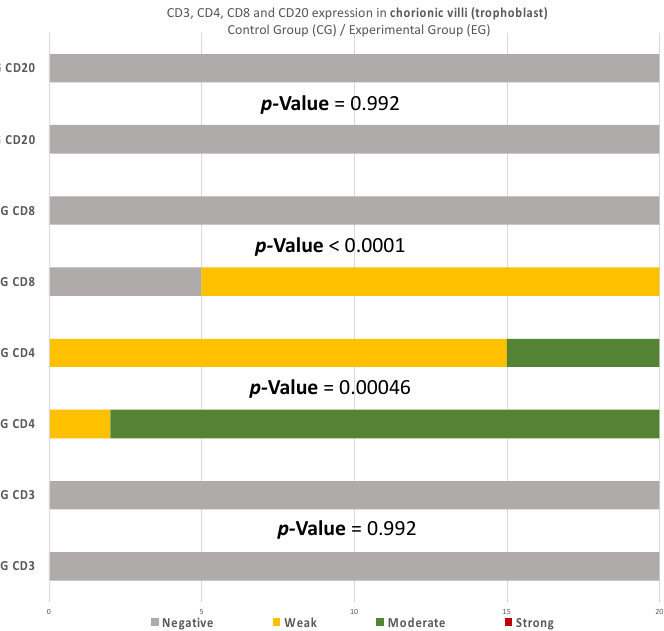
at p -value < 0.05.